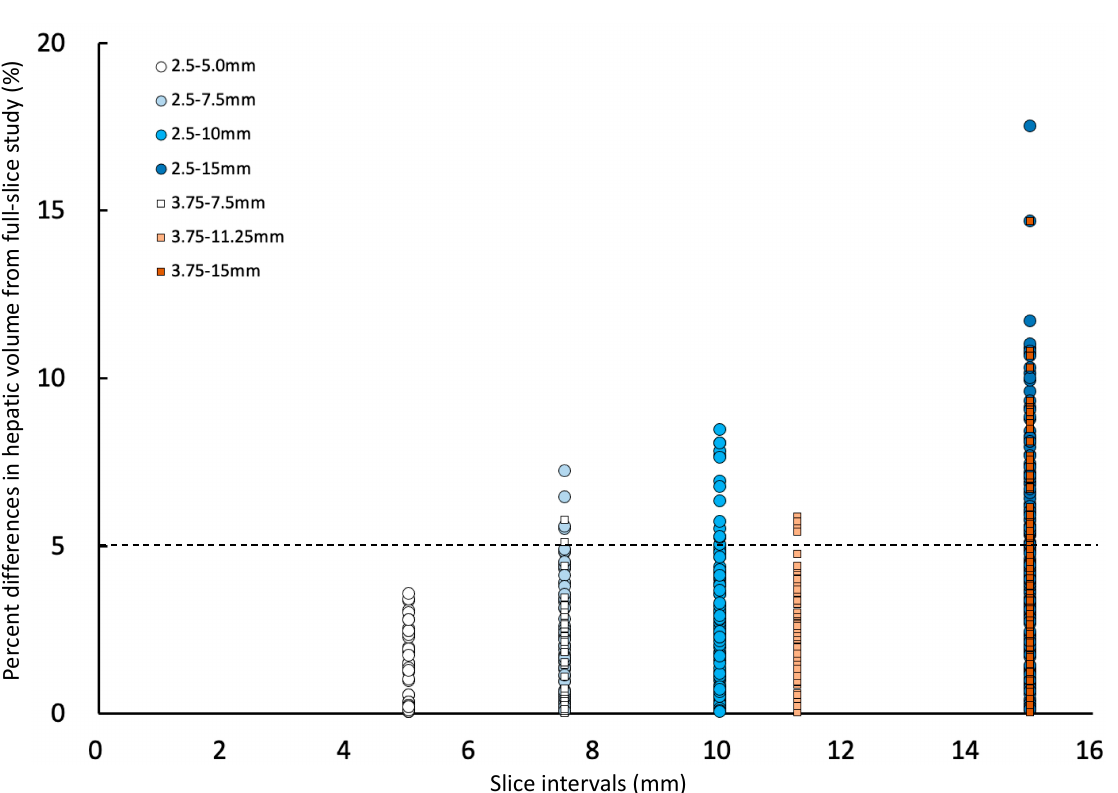
interval (2.5–10 group), 5.9% at 11.25 mm slice interval (3.75–11.25 group), and 6.7% at 15 mm slice interval (2.5–15 and 3.75–15 groups). The greatest percent difference in hepatic volumes was largest at 10 mm slice interval, larger than 11.25 and 15 mm slice intervals (Figure 3).